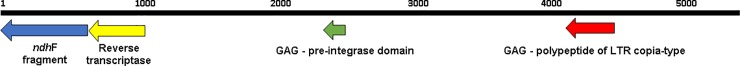
Results of BLASTX search of scaffold1075174 (length 5,436 bp): Putative domain hits are indicated by the colored arrows.